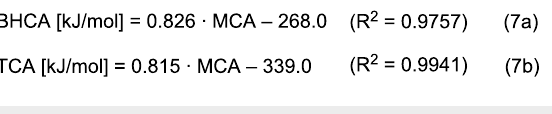
Scheme 7: Correlations of BHCA/TCA values with the respective MCA data for sterically unbiased systems (excluding DABCO ( 44 ) and triethylamine ( 45 )).